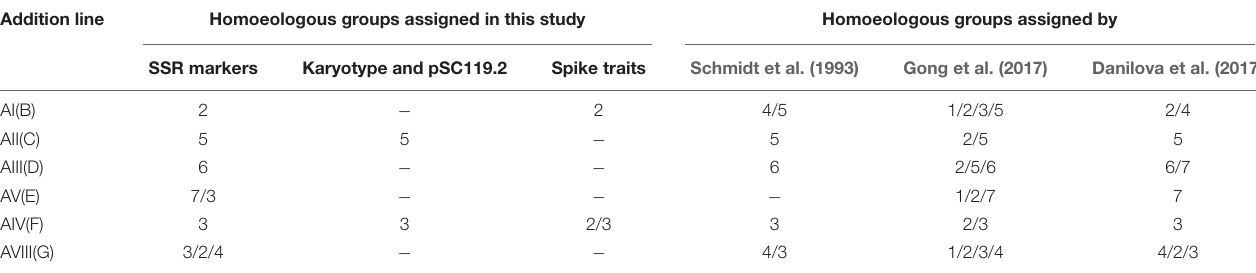
Assignment of homoeologous groups using karyotype and pSC119.2 probe was based on the Ae. markgrafii reference karyotype (Molnár et al., 2015).